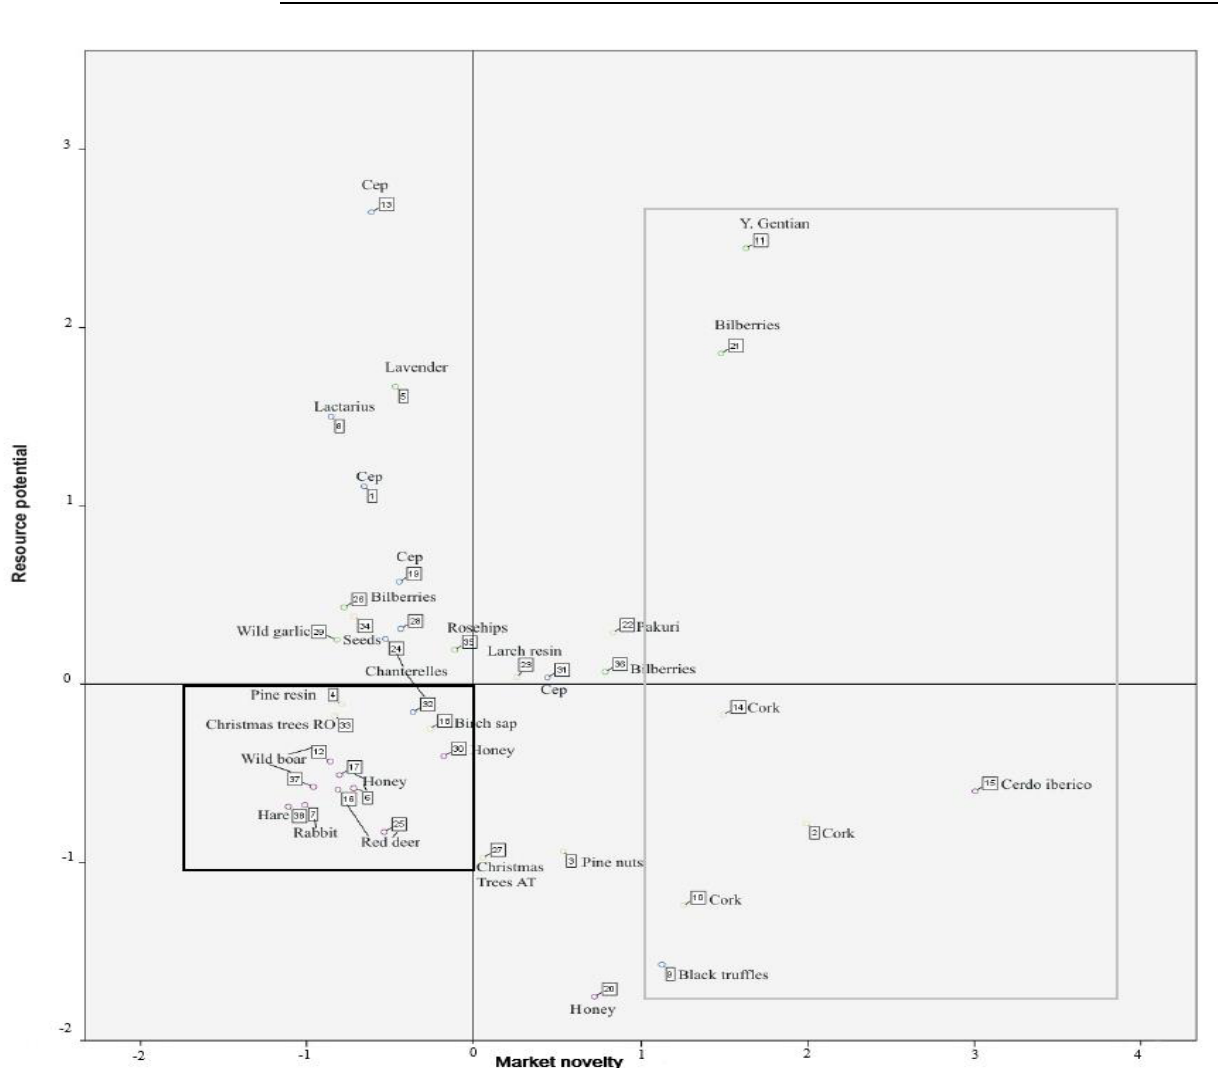
Figure 3. PCA results for NWFPs indicating factor scores of their principal components (i.e., perfor- mance on the dimensions of “market novelty” and “resource potential”). Frames indicate clusters of NWFP categories (i.e., bold frame = low-cost/low-value, grey frame = high-cost/high-value). Principal component loads for NWFPs depict at least two “clusters” of product cate- cost/high-value (dashed frame). Under (i), NWFPs such as game species and honey can be seen that do not require high skills and know-how, nor do they require very large in- vestments. Related resources appear to be abundant, widespread and rather quickly avail- able. However, the added value that might be gained via marketing of related NWFPs tends to be limited. This may be due to a narrow range of less competitive, less innovative value-chains of more traditional products marketed at local to regional levels. Group (ii) pinpoints exclusive NWFPs that call for high levels of expertise as regards both manage- ment and harvesting. Resources thereof mirror some kind of uniqueness, whether in terms of endemism (e.g., cork, black truffle, cerdo ibérico) or specific attributes like chemical composition for instance (e.g., yellow gentian, North Karelian bilberries) that may con- tribute to the high added value of related end-products or to expanding the value chain of the respective product (e.g., more end-products). Both aspects underpin the competi- tiveness of (inter)nationally marketable products. Taking into consideration the classifica- tion of NWFPs beyond taxonomic kingdoms, as is also the case in this study, it appears evident that forest management and the potential for co-production of wood and non- wood resources are key drivers to supporting the further development of NWFP value networks. Adding forest owners´ perspectives to the PCA, and linking it towards forest management decision making, the results support further categorisation of NWFPs into (i) spontaneous resources that are collected opportunistically and compatible with timber- centred forest management (such as wild herbs, berries, nuts, mushrooms); (ii) resources that are actively produced in forests and thus require specific management operations